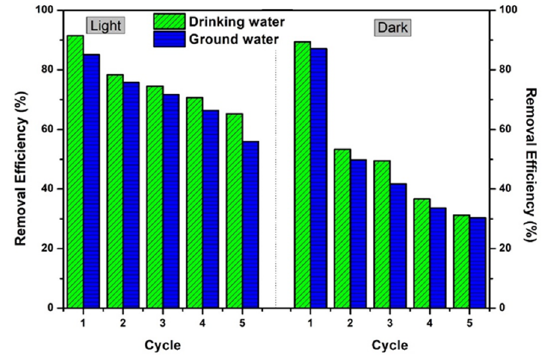
Figure 10. Removal of KP in drinking and groundwater using CTG–500 membrane.